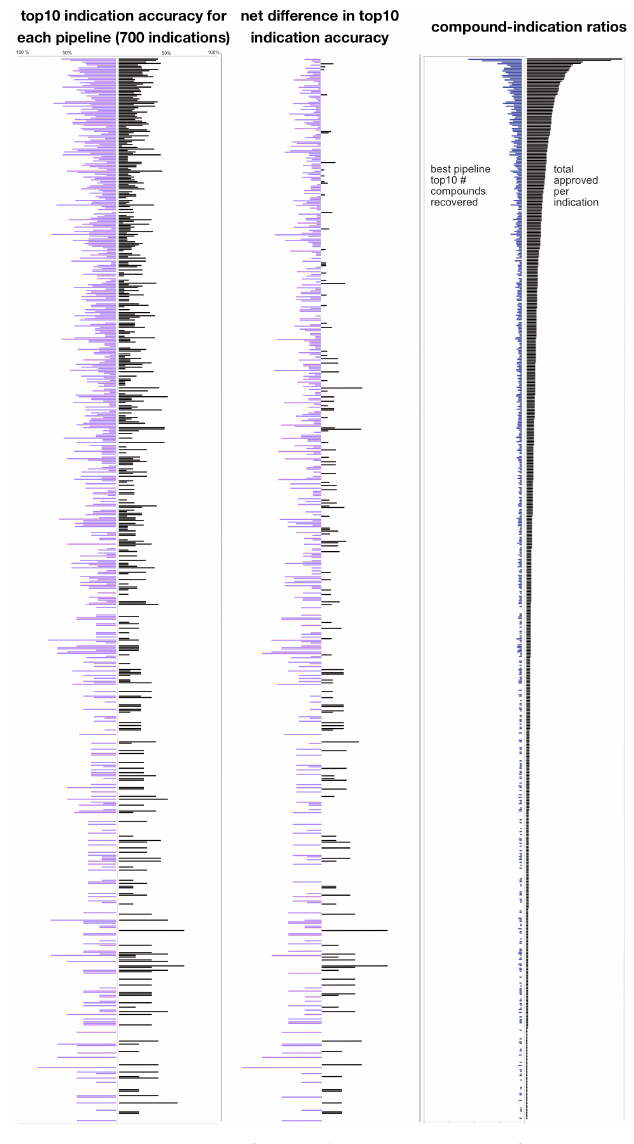
Figure 4. Comparison of 700 indication accuracies for two CANDO platform pipelines at the top10 cutoff. The top10 indication accuracies for 700 indications produced by the Vina-134 and v1.5-134 pipelines are shown in the left panel, with the the v1.5-134 pipeline per indication accuracies in purple on the left side and the Vina-134 pipeline accuracies in black on the right. The net difference in pipeline accuracy for the same indication is shown in the center panel, using the same percentage scale as the left. The number of drugs recovered by the best performing pipeline (in blue on the left side) and the total number of drugs approved per indication (in black on the right side) are shown in the right panel. The number of approved drugs for all three panels ranges from 158 drugs at the top to two drugs at the bottom. Generally, the v1.5-134 pipeline outperforms the Vina-134 pipeline, both by the number of indications and net difference in accuracy per